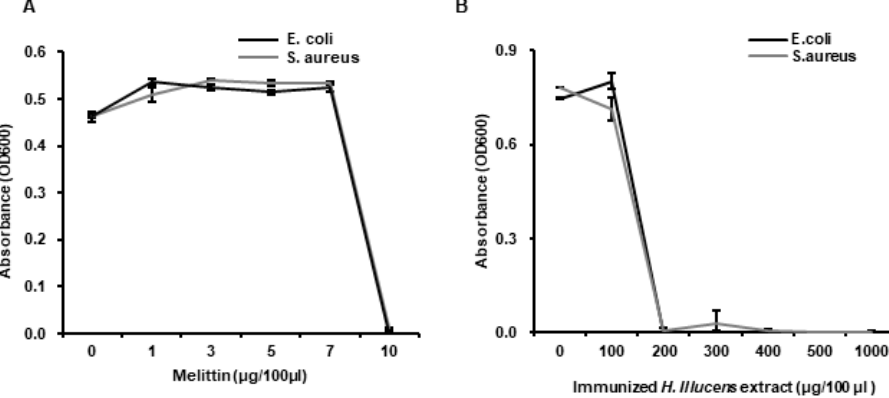
Figure 4. Determination of the minimal inhibitory concentrations (MICs) of melittin ( A ) and L. casei -immunized HIL extract ( B ). Various concentrations of 10 µL melittin or 10 µL L. casei -immunized HIL extract (10 µL) were mixed with 90 µL of liquid media containing 1 × 10 6 cfu/mL of E. coli or S. aureus and incubated at 37 °C for 24 h.